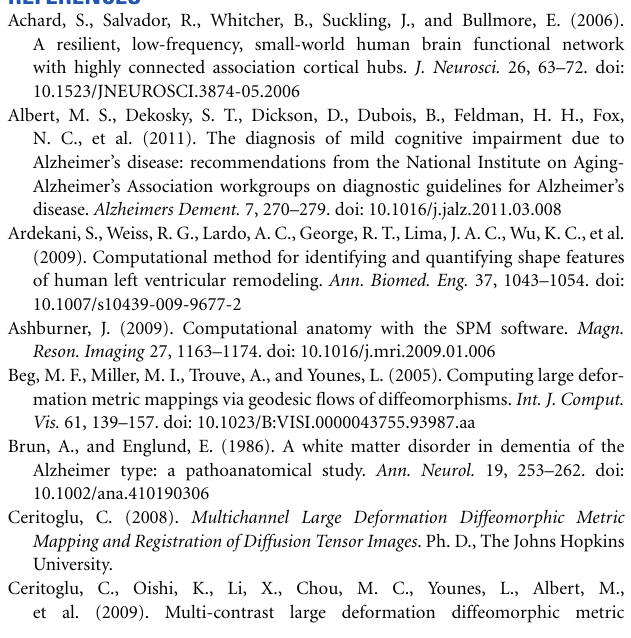
Aphasia—PPA. Regions with significant correlations are colored and the color scale represents the degree of correlation. These data includes part of the dataset used in Race et al.